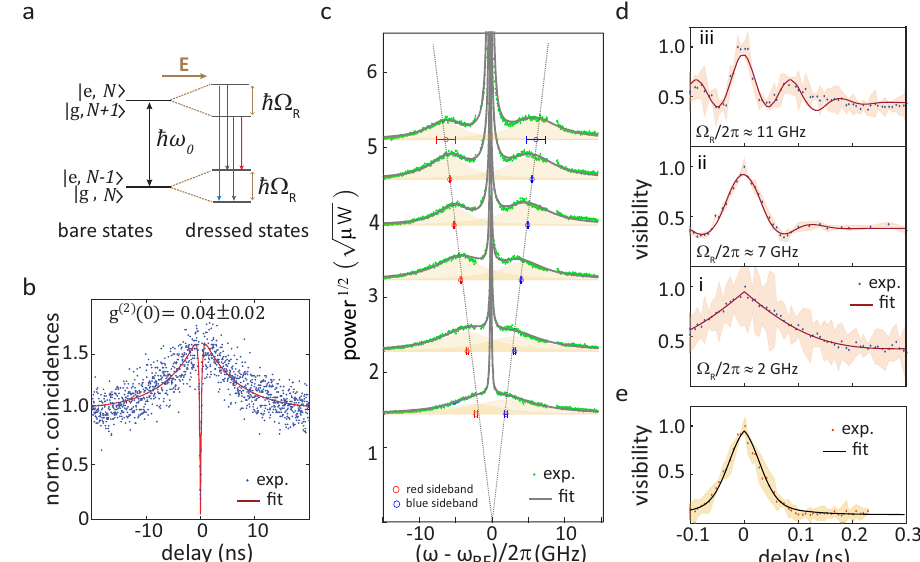
Fig.4|Resonance fl uorescenceandcoherentcontrolofquantumdot.a Energy levels of a two-level system (TLS) driven by a resonant coherent optical driving fi eld. Electric dipole interaction with the driving fi eld ( E ) splitsthe TLS ‘ bare ’ states into two ‘ dressed ’ states separated by ℏ Ω R , producing three emission peaks, represented by different colors. The labels e, g and N respectively correspond to the TLSground and excitedstates, and thecoherent fi eld average photon number. b Measured second-order correlation and fi t (red line) for the QD emission under resonantexcitation. c Strong-driveresonance fl uorescencespectra(greendots)for increasing excitation powers and fi ts (gray lines). Gaussians used to fi t the side-